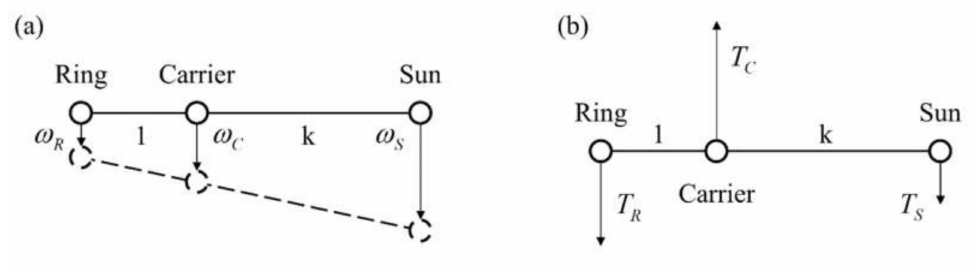
Figure 2. Lever analogy of a planetary gear-set: ( a ) speed relation; ( b ) torque